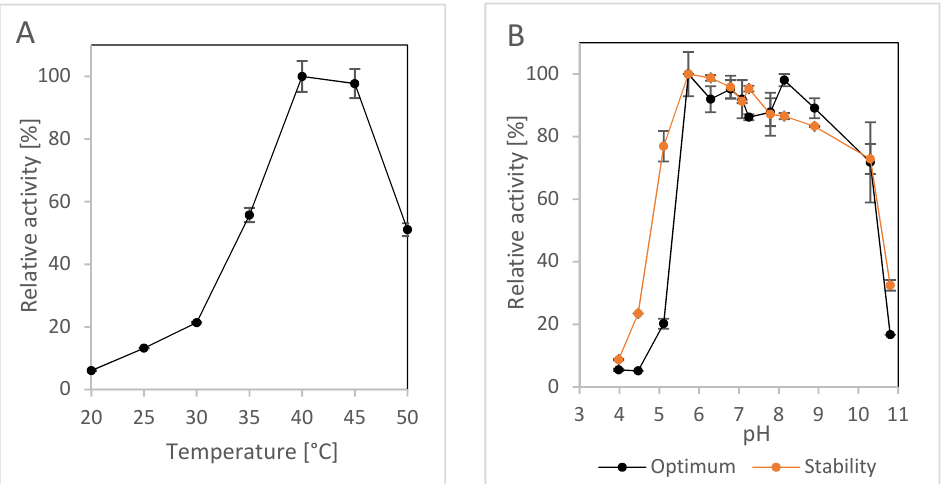
Figure 3. Effect of ( A ) temperature on the activity of enzyme NitEg and ( B ) pH on the activity and stability of NitEg. 2-Cyanopyridine (25 mM) was used as substrate.